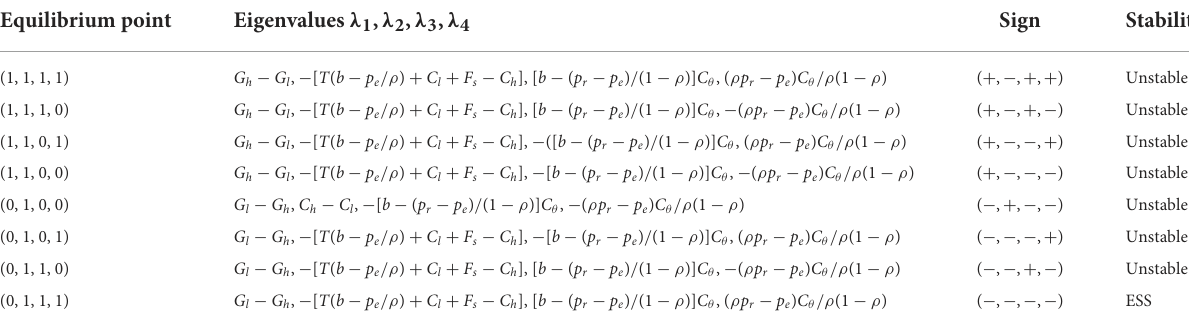
TABLE 3 Asymptotic stability of the equilibrium point in providing high-quality